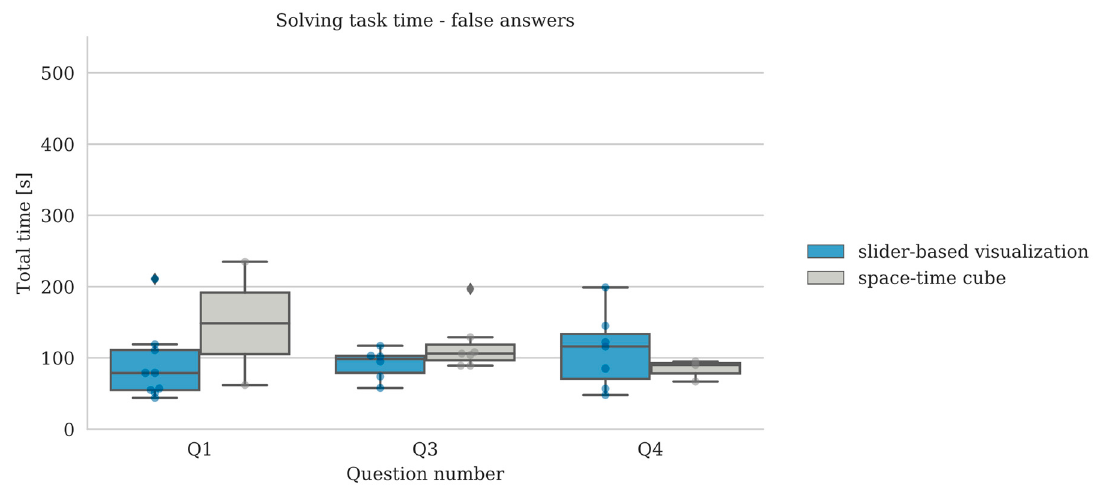
Figure 10. Solving task time to complete the benchmark tasks. The users gave false answers to the questions.